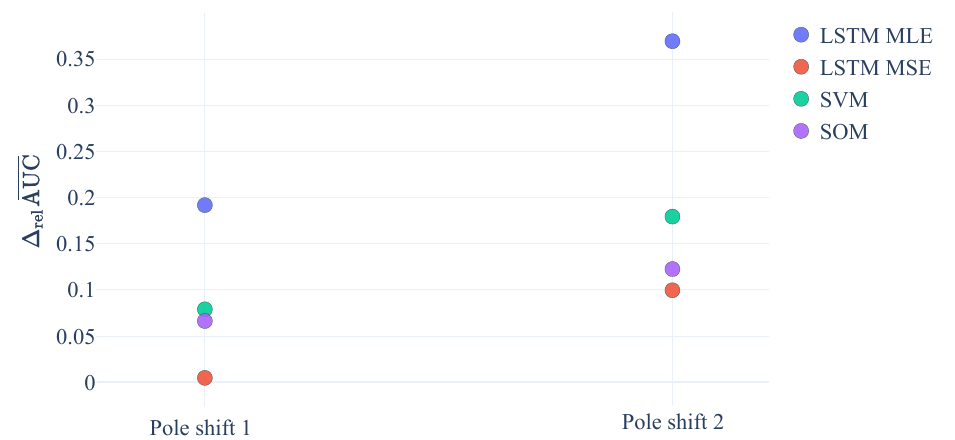
Figure 5. Comparison of Maximum Likelihood Estimation (MLE) versus mean-squared-error (MSE) as function of variations in the number of dimensions in the observation space and pole shift.